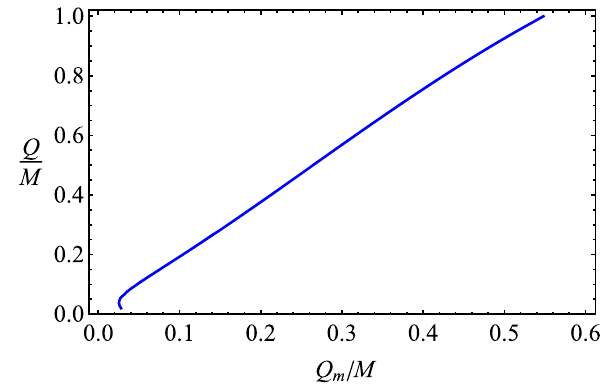
Fig. 9 Relation between magnetic charge and electric charge of the RN black hole providing the same value of the ISCO radius of the magnetized particle for the fixed values of the parameter β = 10 . 2 and b = 0 .